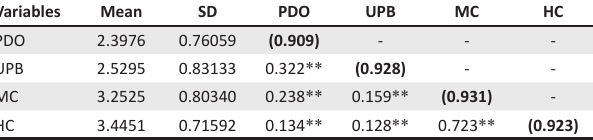
TABLE 2: Means, standard deviations and correlations among study variables.